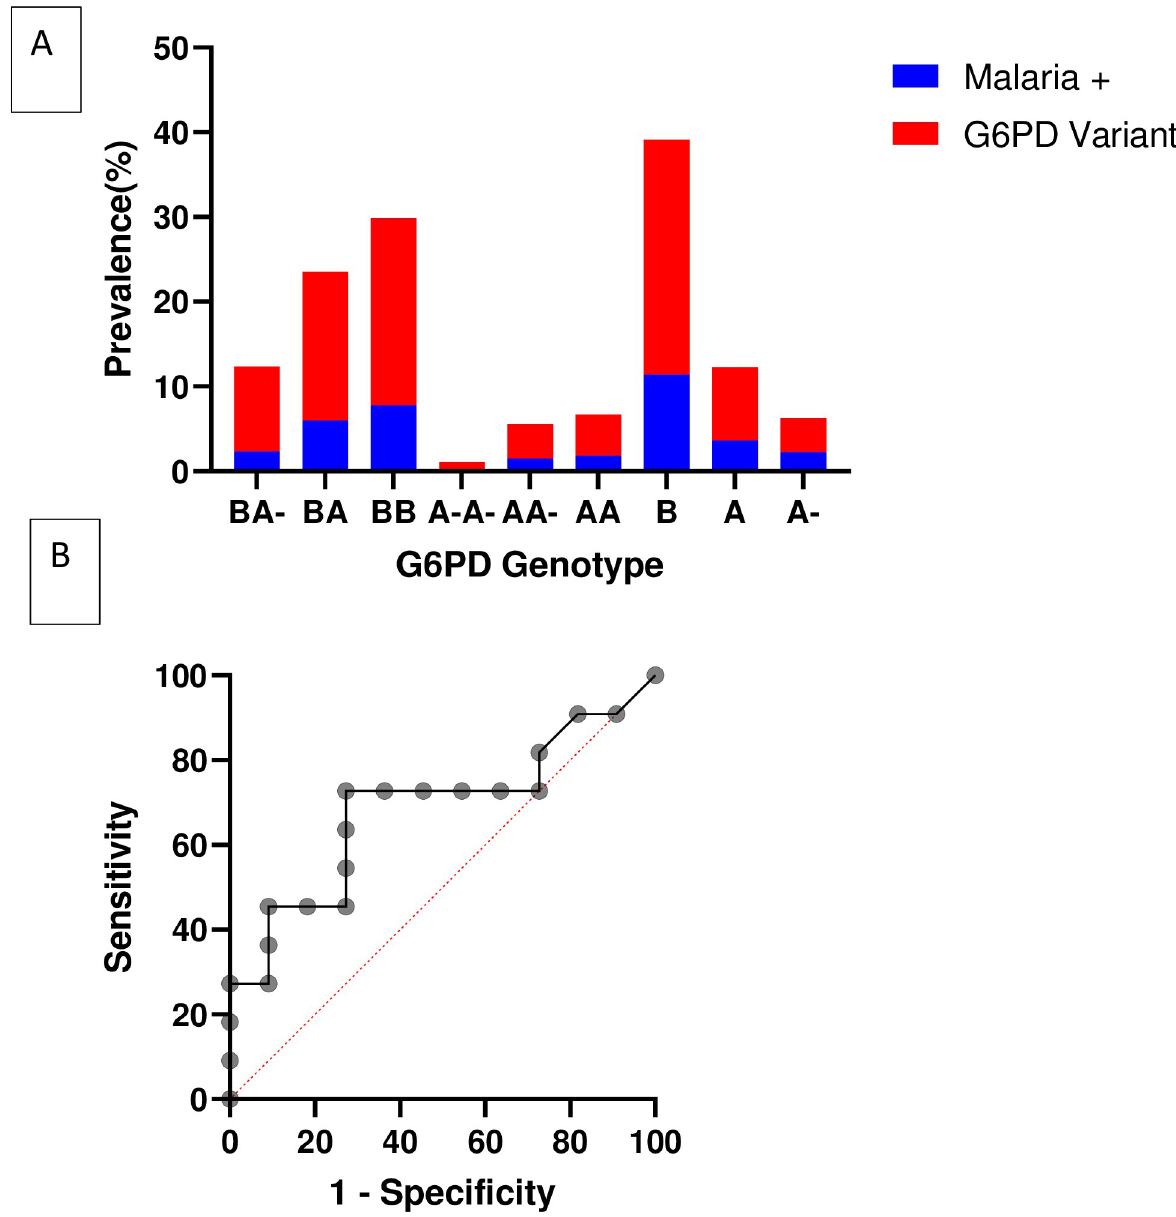
Fig 1. Malaria prevalence among G6PD genotypic variants. A) Prevalence of individual G6PD genotypic variants and their corresponding malaria prevalence. B) Specificity and Sensitivity of detecting malaria infection among the different G6PD genotypic variants using